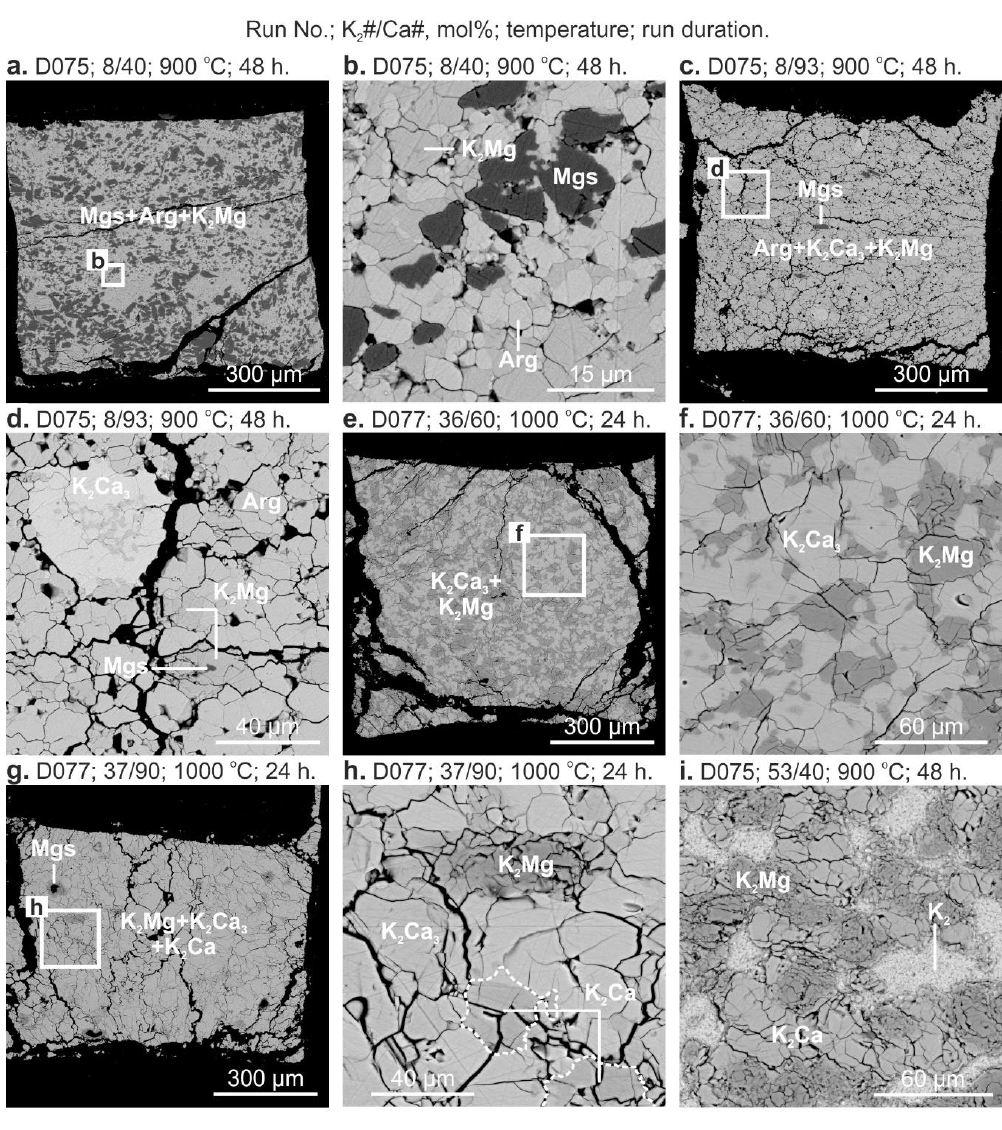
Figure 1. Backscattered electron (BSE) images of sample cross-sections illustrating subsolidus phase relationships in the system K 2 CO 3 − CaCO 3 –MgCO 3 at 6 GPa. The samples represent two runs: D075 at 900 ◦ C with a duration of 48 h (a-d,i); D077 at 1000 ◦ C and 24 h (e-h). K 2 # / Ca# indicates bulk composition of the starting mixture, K 2 # = 100 · K 2 CO 3 / (K 2 CO 3 + CaCO 3 + MgCO 3 ), Ca# = 100 · CaCO 3 / (CaCO 3 + MgCO 3 ). See the Nomenclature section for abbreviations.